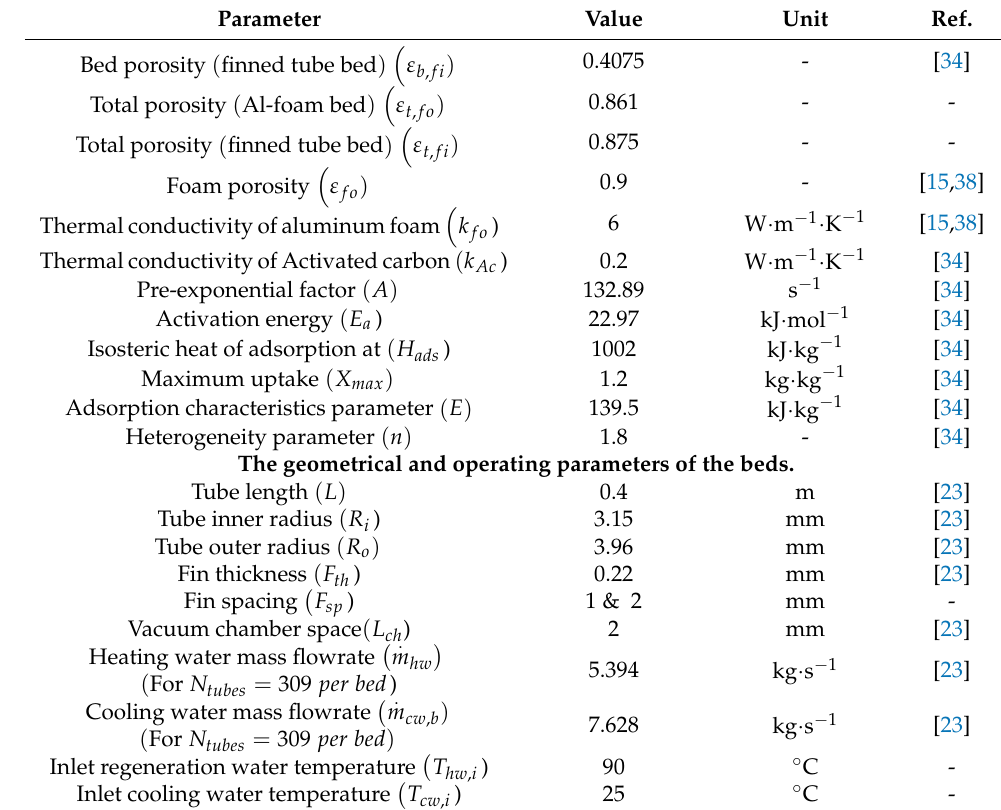
Table 1. Cont . Parameter Value Unit